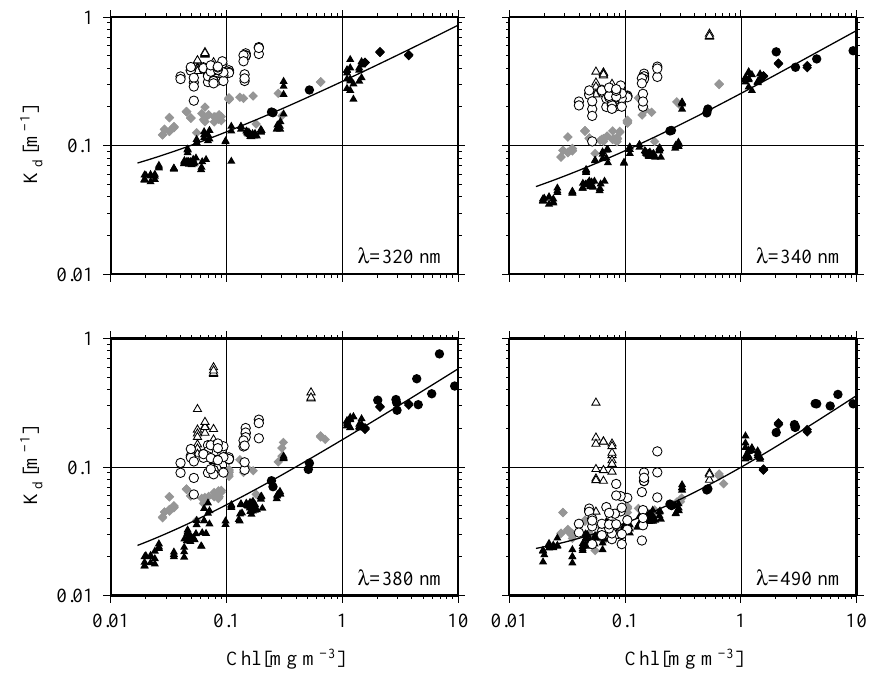
Fig. 10. K d as a function of Chl a , and for selected wavelengths as indicated (redrawn from Morel et al., 2007a, with addition of the data from Malina Leg2b). The open symbols are for the Malina Leg2b clear-water stations, the gray symbols for the Mediterranean Sea, and the black symbols for South Pacific data. The continuous black curve represents the MM01